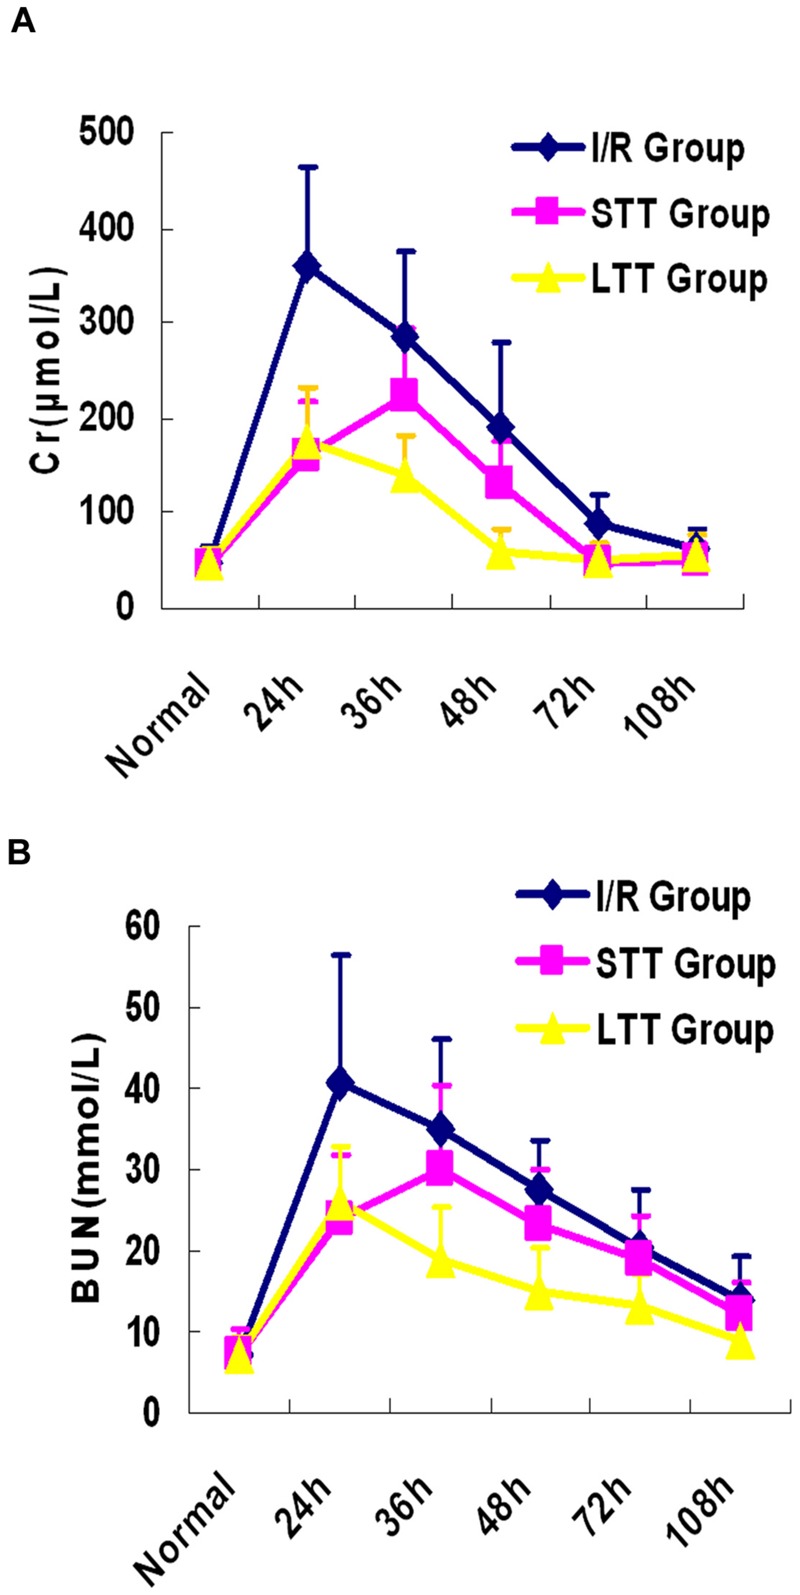
Long-term HRSS treatment attenuated renal I/R injury. Short-term HRSS treatment (STT) after renal I/R injury reduced renal injury, but renal function deteriorated once the treatment was stopped. In contrast, long-term HRSS treatment (LTT) markedly reduced renal injury and accelerated renal function recovery. (A) Blood creatinine. (B) Blood urea nitrogen.